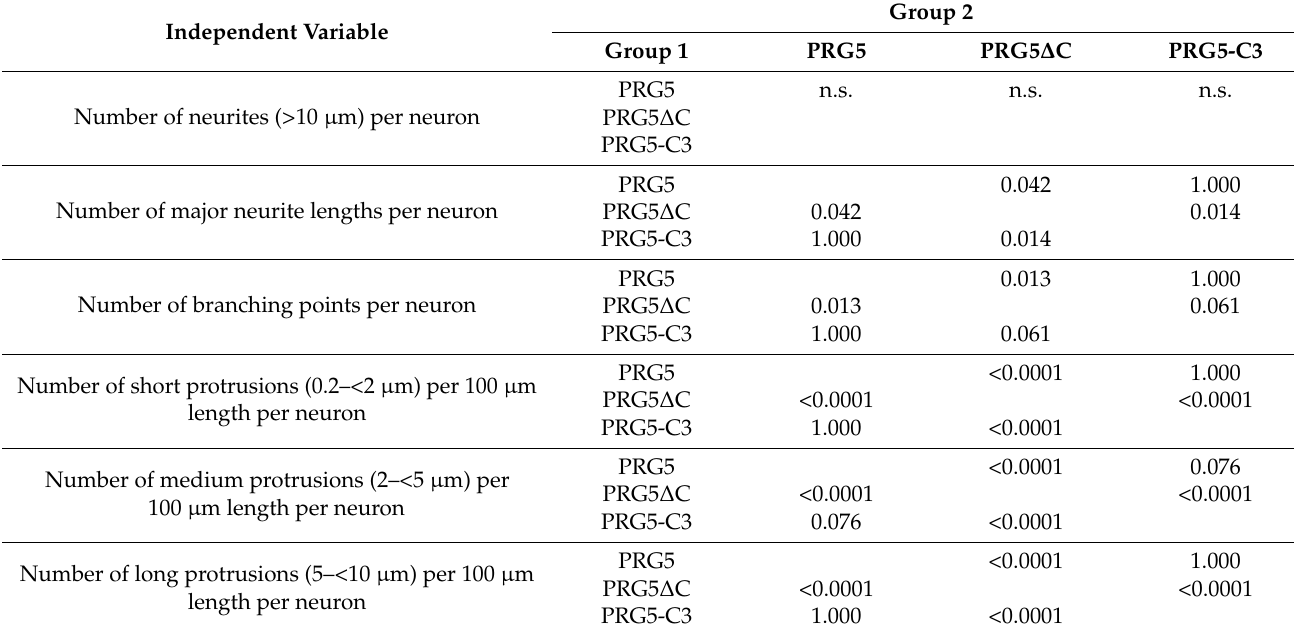
Table 2. Summary of p values of pairwise comparisons obtained by Kruskal–Wallis test followed by a post hoc Dunn’s test of data presented in Figure